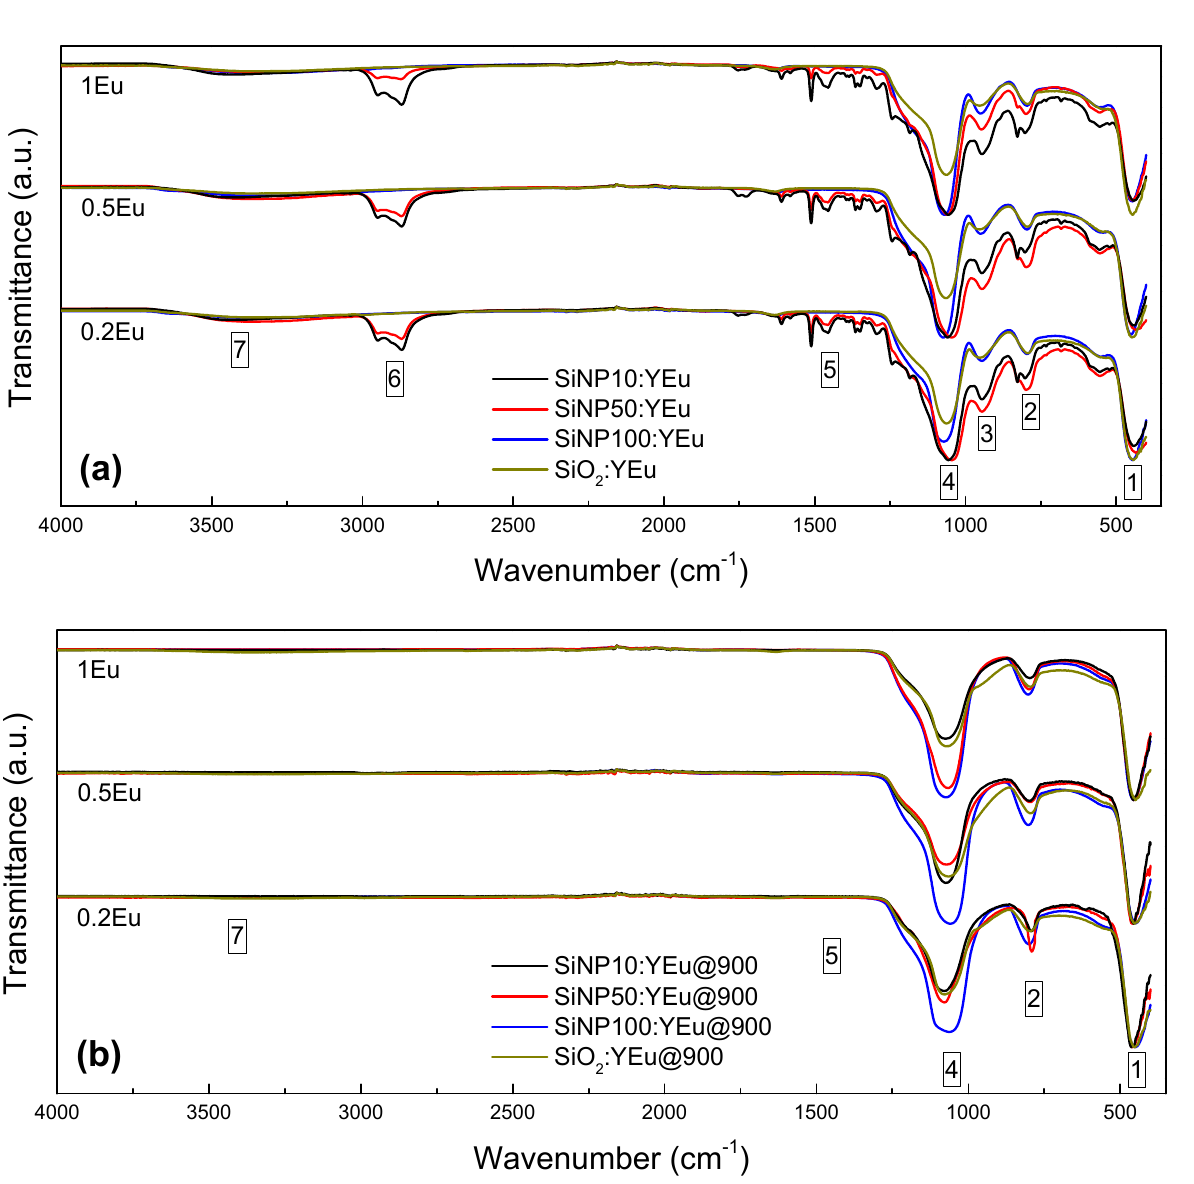
Figure 4. FT-IR spectra at room temperature of all SiNP: ( a ) before thermal treatment; and ( b ) after thermal treatment. Before and after thermal treatment, all SiNPs show the bands associated with the movement of oxygen in the SiO 2 network: the swing “Peak 1” [22], symmetrical elongation “Peak 2” [22] and asymmetrical elongation “Peak 4” [22], as well as the shoulder at approximately 1200 cm − 1 , which is generally interpreted as an additional signature of the amorphous SiO 2 network [17]. Thermal treatment causes displacement of the main peak at about 1100 cm − 1 “Peak 4” to a higher wavenumber: 1059–1081, 1047–1078 and 1068–1079 cm − 1 for SiNP10:YEu , SiNP50:YEu and SiNP100:YEu , respectively. This shift is explained by a decrease in the structural disorder of the amorphous silica with a variation of the bridging Si-O-Si bonding angle and a decreasing of the defects [18–20]. This decrease in disorder was also observed by DRX. In addition, we observed in all non- calcined samples the bands associated with the presence of OH groups. In addition, we can note that “Peak 3” corresponds to the symmetrical elongation of the Si-OH bond [22] “Peak 5” to the deformation of the OH bonds of the adsorbed water [22] and “Peak 7” to the overlap of the elongation peak of the OH hydrogen bond from water molecules adsorbed by the samples and the elongation peak of hydrogen from the silanol groups (Si- OH) within the glass [22].